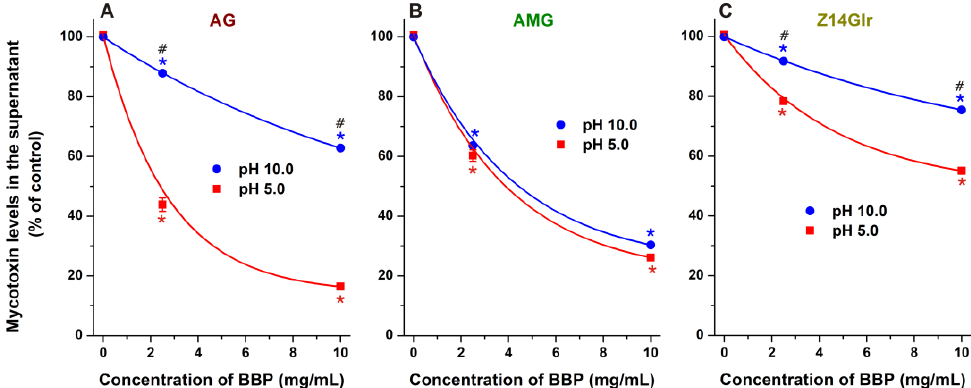
Figure 9. Extraction of alternariol-3-glucoside (AG; ( A )), alternariol-9-monomethylether-3-glucoside (AMG; ( B )), and zearalenone-14-glucuronide (Z14Glr; ( C )) by insoluble β -CD bead polymer (BBP) from sodium acetate (pH 5.0) and sodium borate (pH 10.0) buffers (mycotoxins concentration: 5 μM). Data represent the mean and standard error of the mean (SEM) ( n = 3). Statistical significance was established based on one-way ANOVA with Tukey’s post hoc test (* p < 0.01: significant difference compared to the control; # p < 0.01: significant difference between the toxin removal at pH 5.0 and pH 10.0 ).